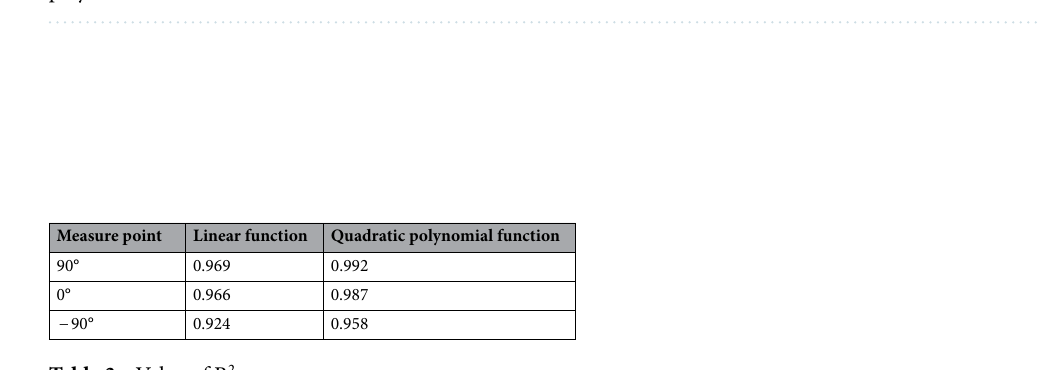
Figure 7. Relationship between surge impact pressure and water depth ( a ) linear function ( b ) quadratic polynomial function.